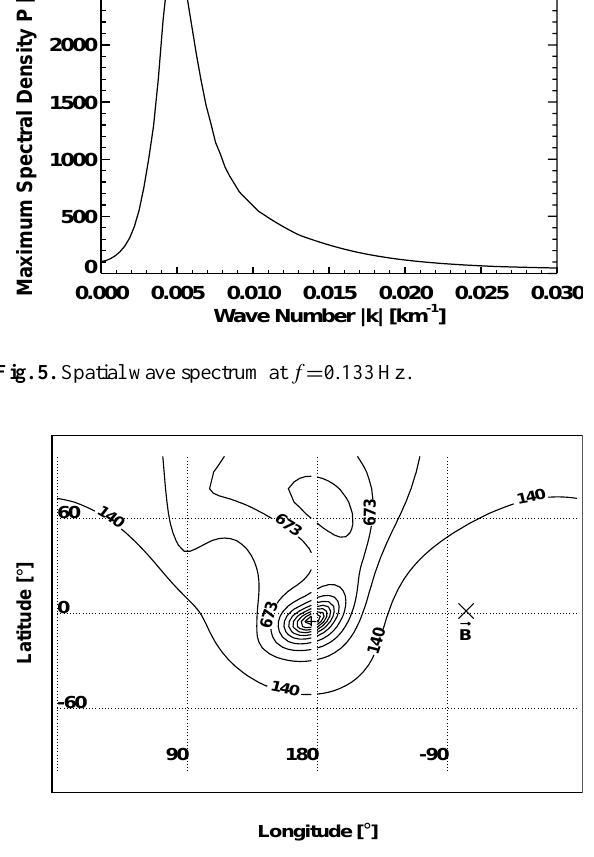
Fig. 6. Spatial power distribution of f = 0 . 133Hz and k = 0 . 005km − 1 . The cross denotes the direction of the ambient magnetic field B